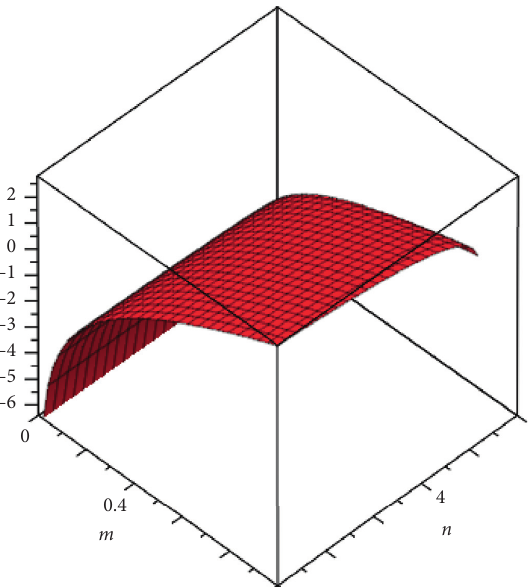
Figure 4: Plot of entropy of TUC